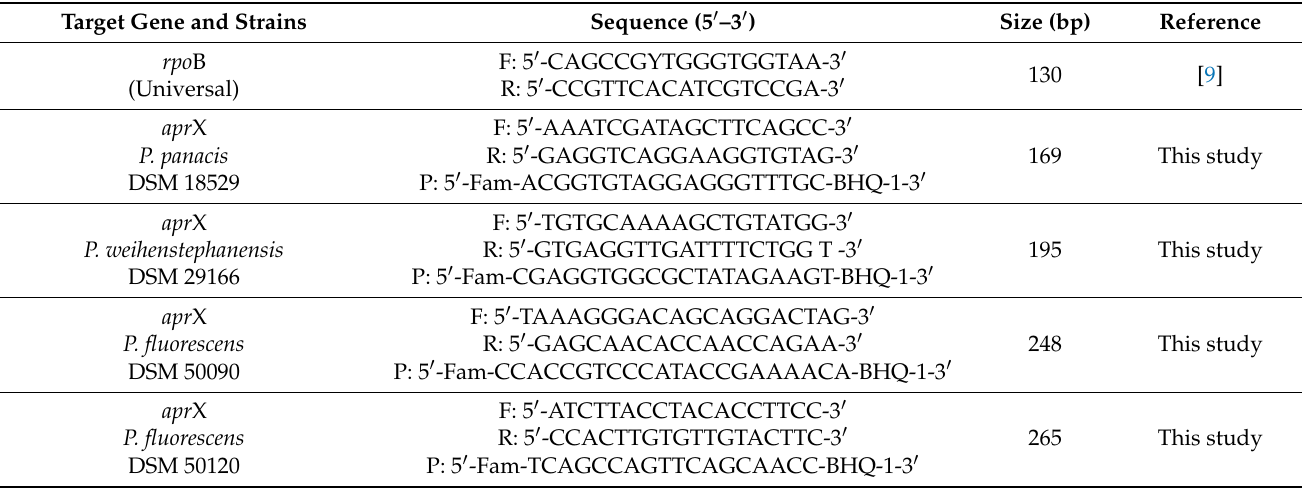
Table 1. Primers and probes used in RT-qPCR to determine rpo B and apr X gene expression in Pseudomonas . Primers: forward (F), reverse (R) and probe